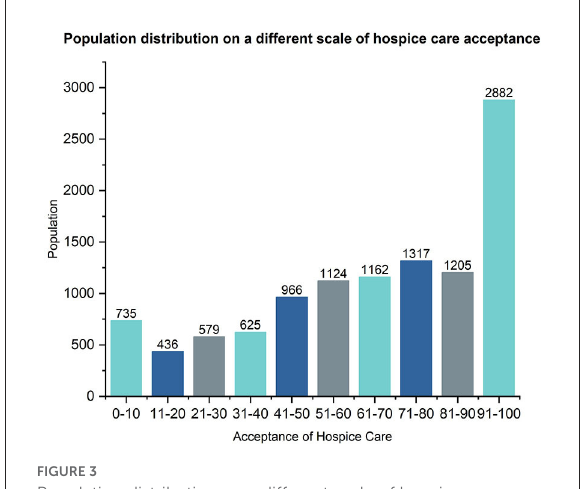
FIGURE3 Population distribution on a different scale of hospice care